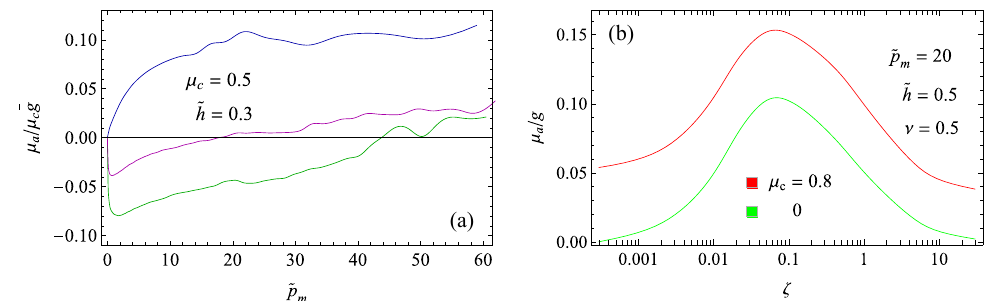
Figure 6. ( a ) the normalized elastic friction coefficient µ a / µ c ¯ g as a function of the dimensionless Figure 6. (a) the normalized elastic friction coefficient µ a / µ c ¯ g as a fuction of the dimensionless contact mean pressure ˜ p m = 2 contact mean pressure ˜ p m = 2